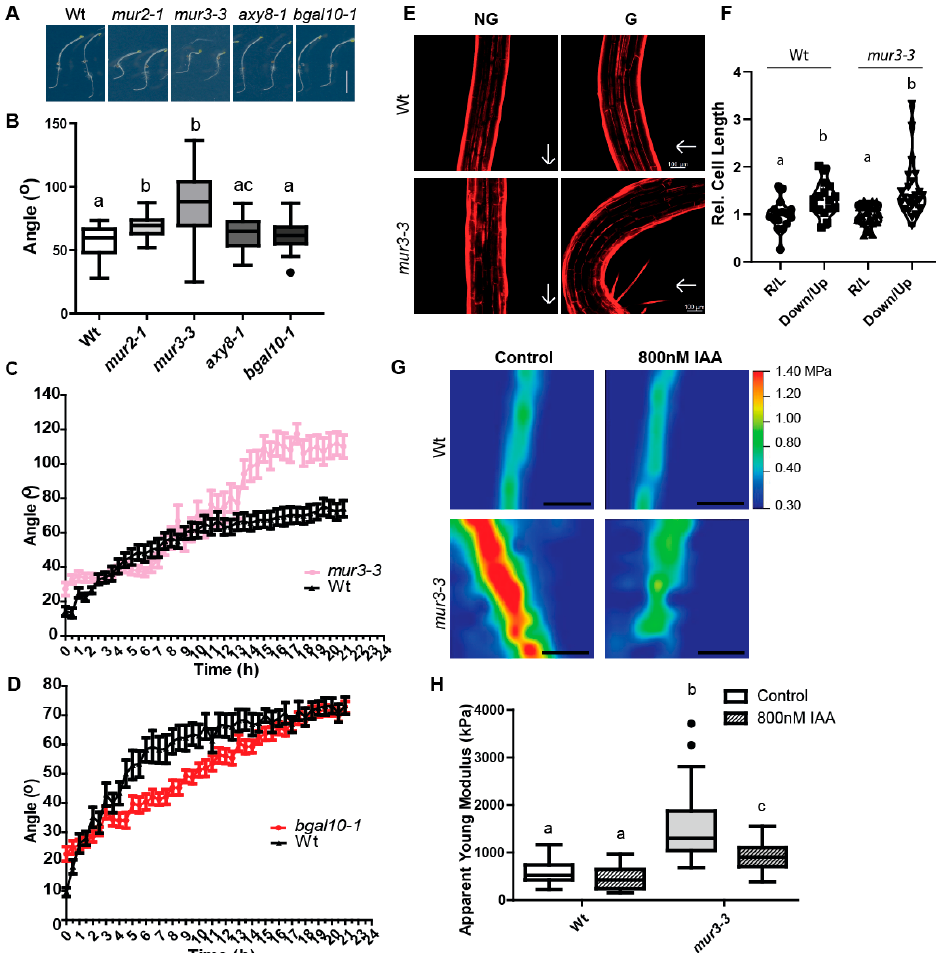
Figure 3. Response to gravistimulation of murus2-1 (mur2-1) , murus3-3 (mur3-3) , altered xyloglucan8 (axy8-1) and beta-galactosidase10-1 (bgal10-1) . ( A , B ) Five-day-old dark-grown hypocotyls were challenged with a 90 ◦ angle change in growth orientation and the end point angle between the apex of the hypocotyl and gravity vector was measured 24 h later. ( A ) Representative images of the angular hypocotyl growth after 24 h. ( B ) Quantification of the end point angle. Tukey box-plot. One-way ANOVA followed by Tukey’s test. p -value < 0.05. Scale bar = 5 mm ( n = 3 biological replicates with 20–30 angle measurements each). ( C , D ) Growth kinetics of mur3-3 ( C ) and bgal10-1. ( D ) Five-day-old dark-grown hypocotyls were challenged with a 90 ◦ angle change in growth orientation and placed in an infrared-based dark-imaging box where their growth was recorded. The angle reached every 30 min was quantified. Non-linear fit to a one-phase association curve. K values for each curve were compared. p -value < 0.05. Data are mean ± SEM ( n = 3 biological replicates with 12–28 seedlings each). ( E , F ) Cell elongation of Wt and mur3-3 after gravistimulation. Five-day old etiolated hypocotyls were challenged with a 90 ◦ angle change in orientation and left overnight, and then stained with propidium iodide. ( E ) Representative images. Scale bar = 100 µ m. ( F ) Quantification of relative cell length. Between 2–3 cells from the cortex region were measured on the right (R) side and left (L) side of non-gravistimulated (NG) hypocotyls, or from the downwards side (Down) or upwards side (Up) of gravistimulated (G) hypocotyls. The average of relative cell length between right and left (R/L), and down and up (Down/Up) is reported. Data are mean ± SD ( n = 3 biological replicates of cell length ratios corresponding to 20–22 seedlings). Kruskal–Wallis one-way ANOVA followed by Dunnett’s test; p -value < 0.05. ( G , H ) Atomic force microscopy (AFM) analysis of mur3-3 . Dark-grown hypocotyls of mur3-3 and Wt Col-0 were grown for three days on 800 nM indole-3-acetic acid (IAA) or dimethyl sulfoxide [DMSO, (Control)]. ( G ) Representative apparent Young’s modulus heat maps of one cell wall region perpendicular to the indentation axis and parallel to the growth axis (periclinal cell wall). Scale bar = 5 µ m. ( H ) Quantification of apparent Young’s modulus in kilopascal (kPa). Tukey box-plot. One-Way ANOVA followed by Tukey’s test; p -value < 0.05 ( n = 3 biological replicates with 30–40 AFM scans). Similar letters in the graphs mark no significant statistical difference. Different letters in the graphs mark significant statistical difference with a p -value <